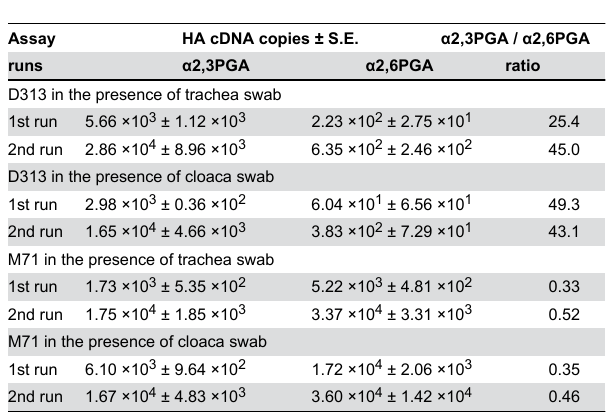
Table 1. Reproduction of receptor binding specificities of D313 and M71 measured by the new assay in the presence of